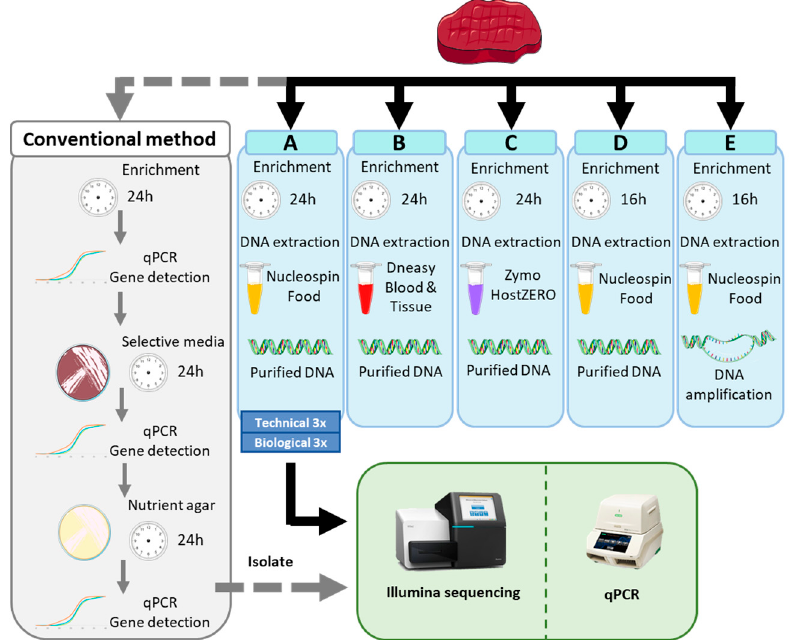
Figure 1. Presentation of 5 di ff erent workflows for the preparation of metagenomics samples of spiked beef (light blue) and the conventional method for Shiga toxin-producing Escherichia coli (STEC) detection and characterization based on several steps of qPCR and isolation on selective media (ISO / TS 13136:2012, grey). The extracted DNA (amplified or not, from metagenomics samples or isolate) is tested for quality control (DNA purity, integrity, concentration) before sequencing on the Illumina MiSeq in parallel to a qPCR check for the presence of stx genes